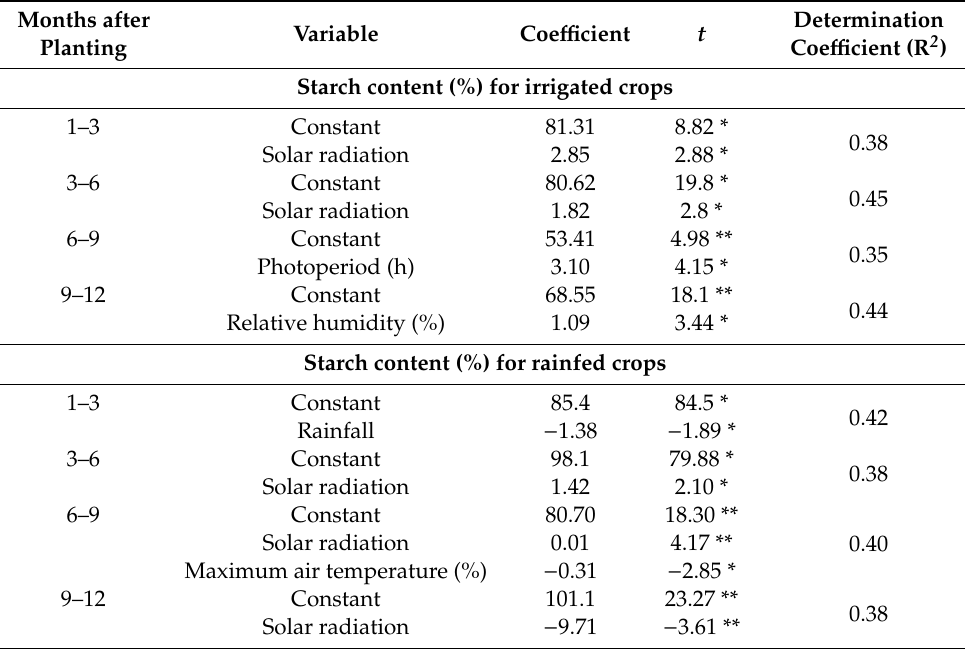
Table 6. The stepwise regression analysis for the starch content (%) and climatic factors of cassava cv. Rayong 9 for both irrigated and rainfed